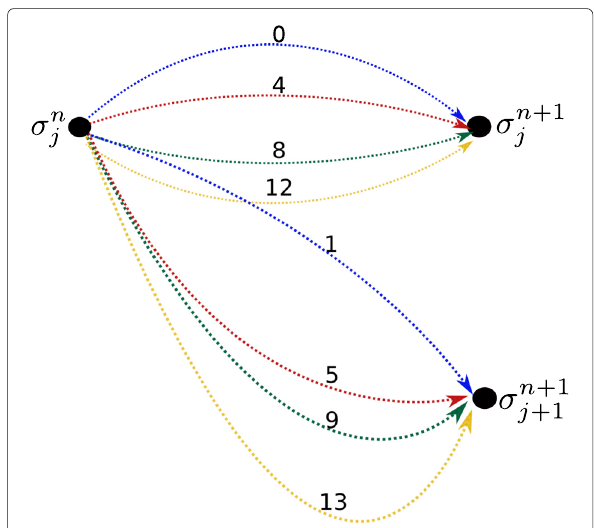
Fig. 7 Representation of the trellis transition for a generic convolutional code C c . In this example, the parallel transitions are defined according to the mapping presented in the previous Fig.